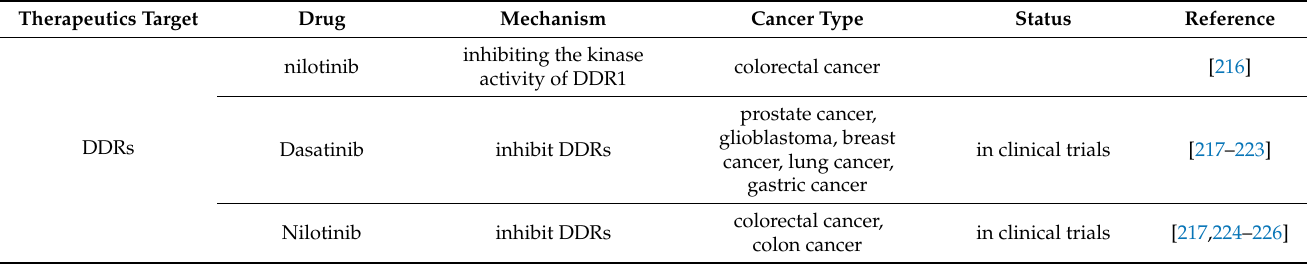
Table 4. DDRs associated therapy and the related drugs in cancer